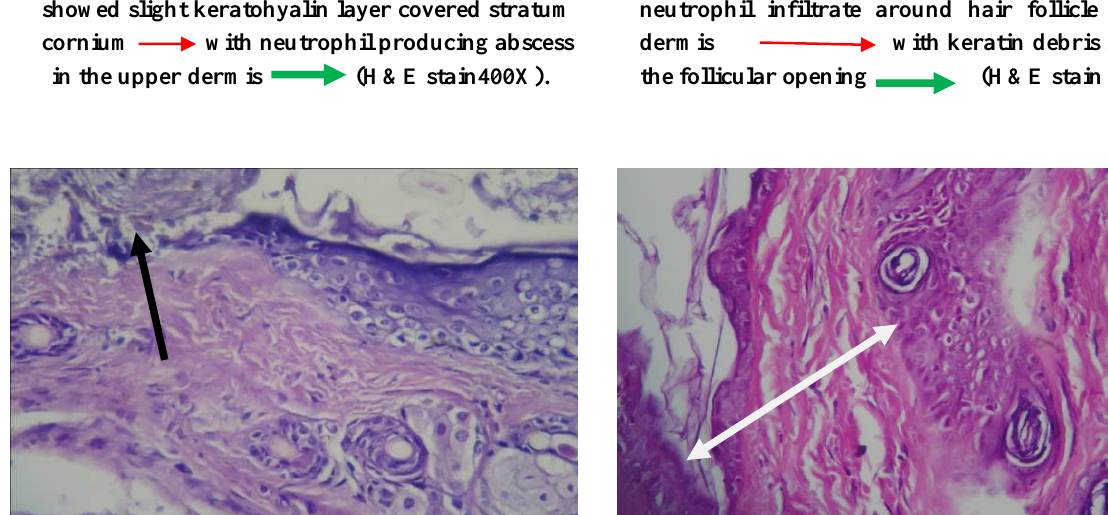
Figure,3: Section in the skin of infected non- immunized infected animal at day 5 post challenge showed focal epidermal ulceration (H&E stain 400X).